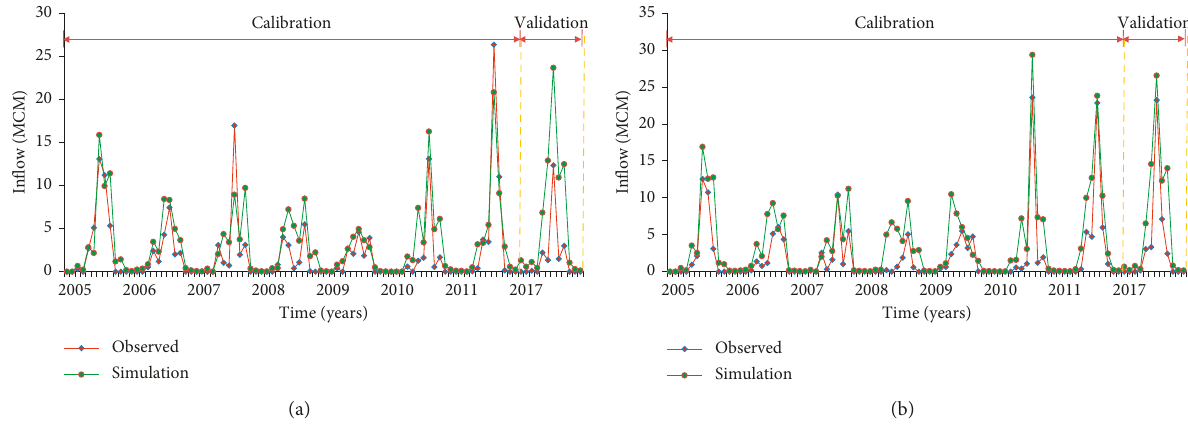
Figure 17: Comparison between inflows from observed stations and SWAT result: (a) Huay Sabag and (b) Huay Ling Jone.